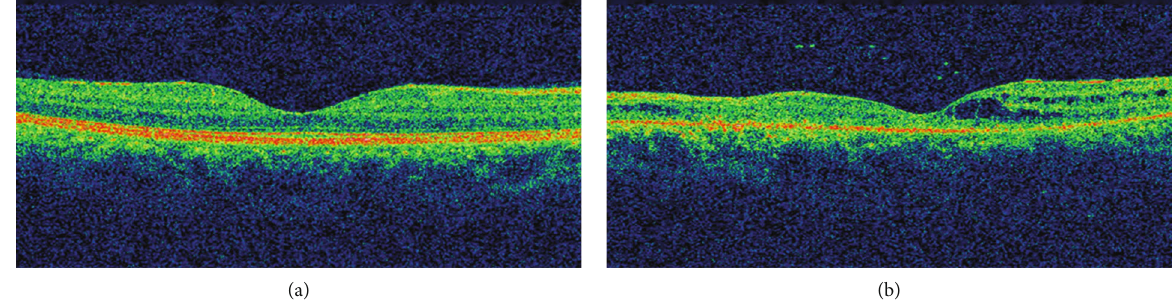
Figure 6: SD-OCT at one and half-year follow-up. (a) Right eye with near normal restoration of foveal anatomy. (b) Left eye showing few cystoid abnormalities but atrophy of the nasal retina.